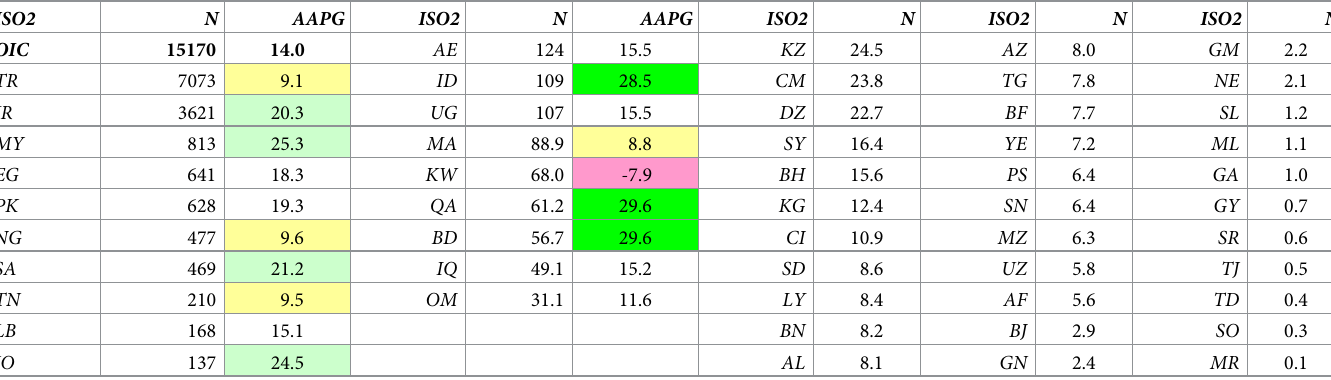
Table 4. Outputs of mental health disorders research papers in the WoS, 2008–17, from the OIC countries, fractional counts, (for ISO codes, see Table 1).